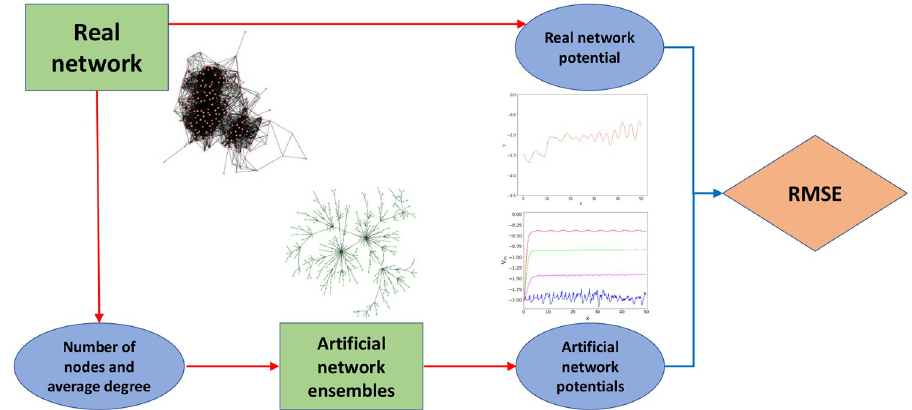
Fig 1. Evaluation of the similarity between a real-world network and different ensembles of artificial networks. The similarity is measured as the average root-mean-square error (RMSE) of the real network potential with respect to the potentials associated with the networks of each ensemble. Moreover, we compare these results with the RMSE between the real network potential and the ensemble median potentials.